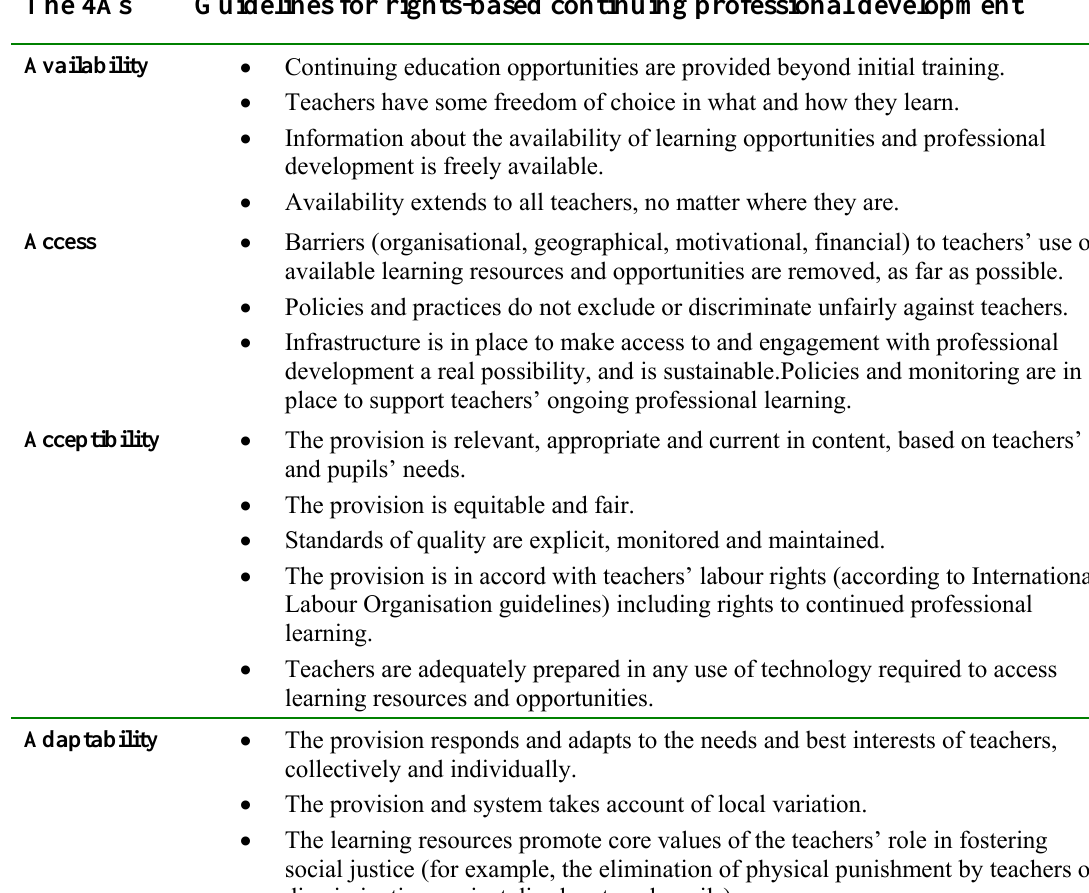
Figure 1. Framework for teachers’ rights to continuing professional development The